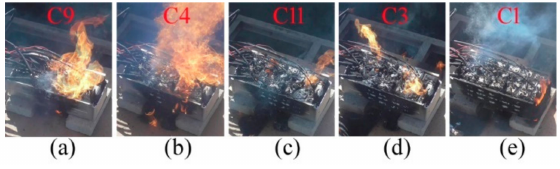
Figure 4. Fire ejection at